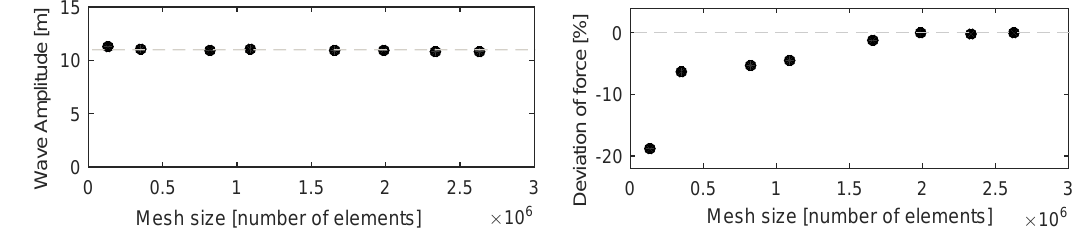
Figure 1. Convergence of the force in the connection line for increasing mesh